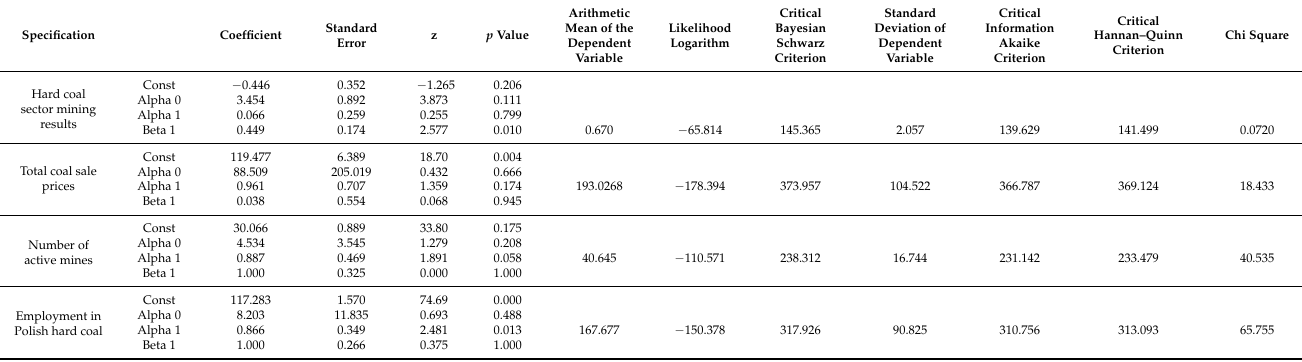
Table 3. GARCH model for analyzed